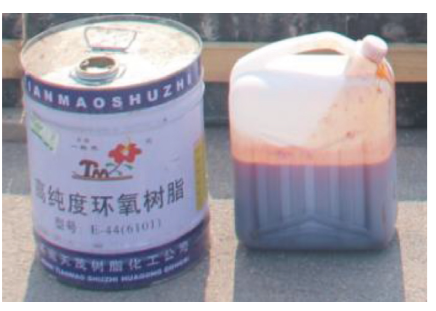
Figure 6: Epoxy. Table 1: Summary of test specimens. Specimen